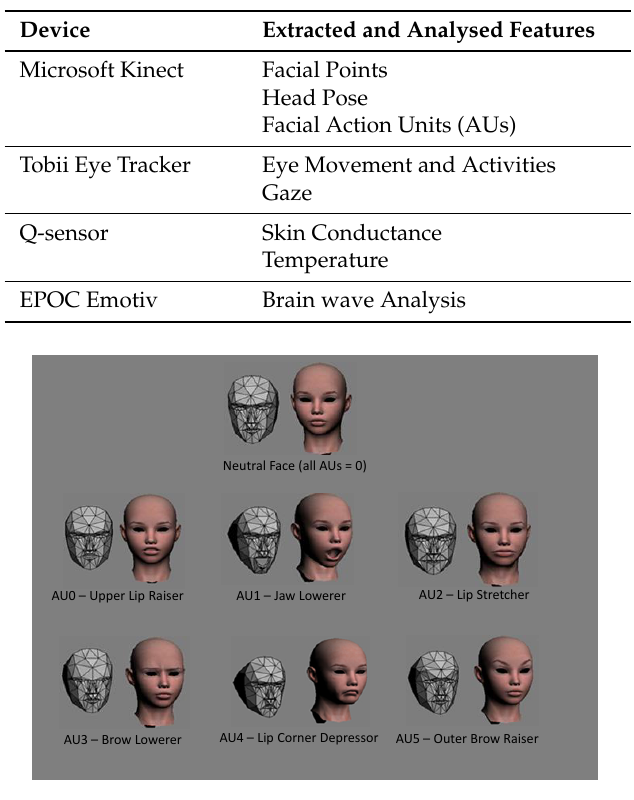
Table 3. Overview of devices used for measuring physiological and behavioural responses.